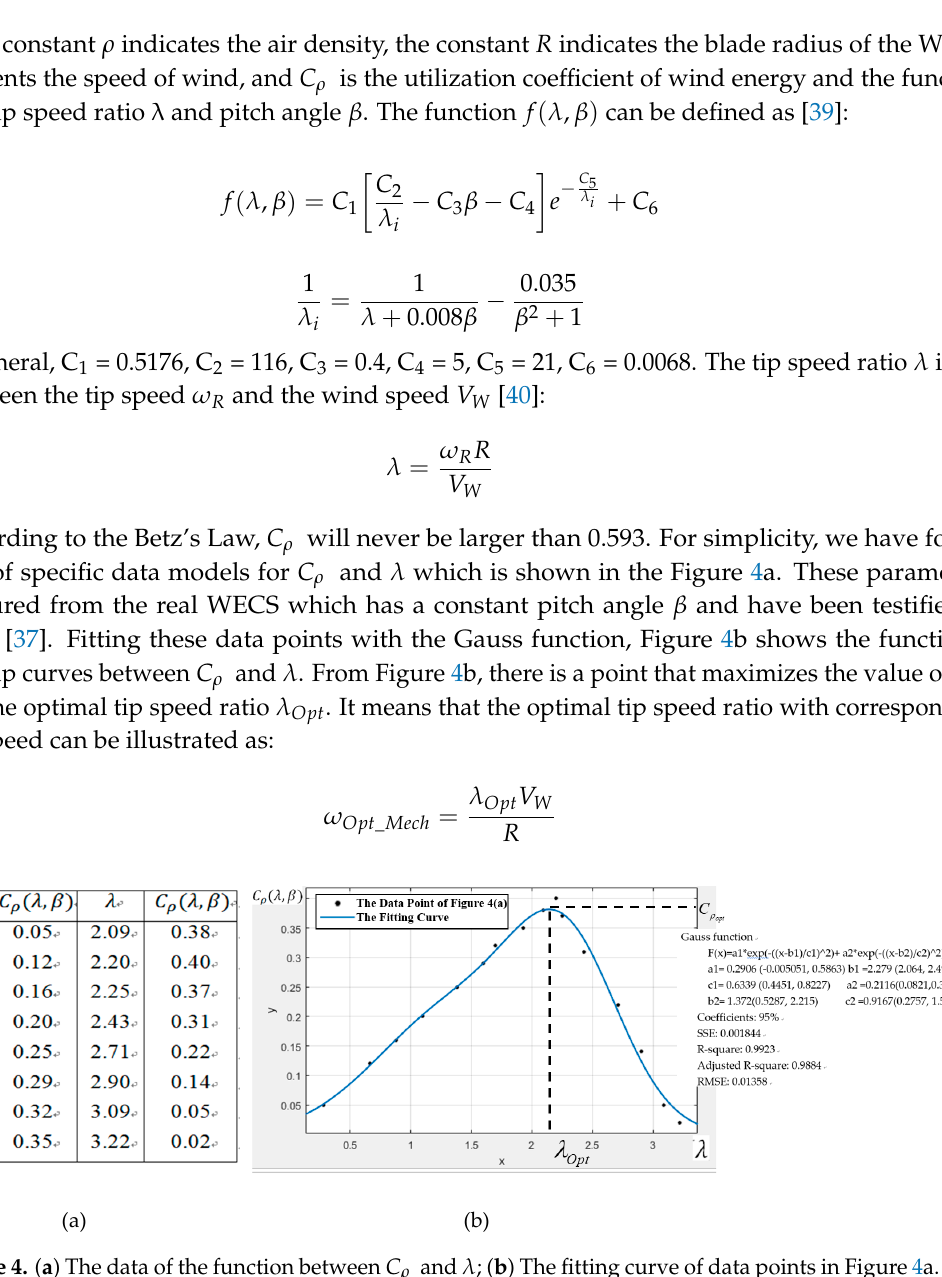
Figure 4. ( a ) The data of the function between ρ C and Figure